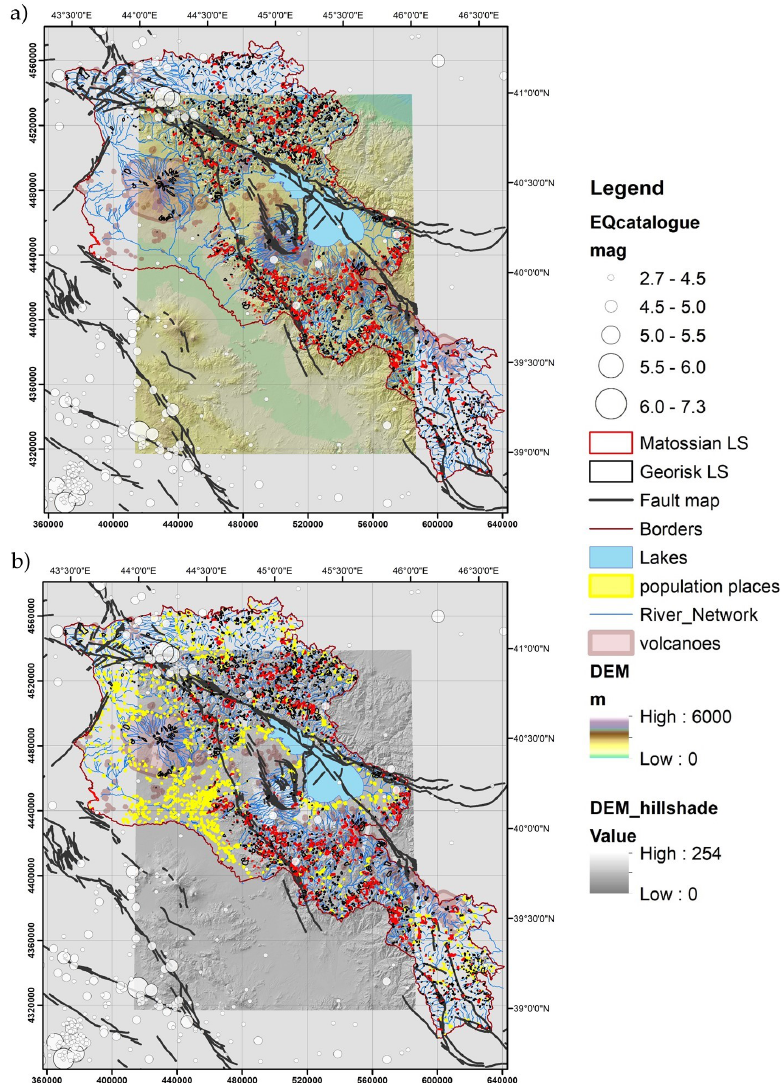
Figure 2. Maps of the Armenian part of the Lesser Caucasus indicating major lakes and rivers (blue), active faults (black lines), earthquake epicenters (semi-transparent white circles with radii indicating earthquake magnitude), landslides recorded in the Matossian (red polygons) and the 2006 Georisk [15] (black polygons) catalogues, and ( a ) volcanoes (brown polygons) or ( b ) populated places (yellow). The 28 m resolution SRTM DEM base layer is colored for elevation in ( a ) and presented as a hillshade in ( b ).